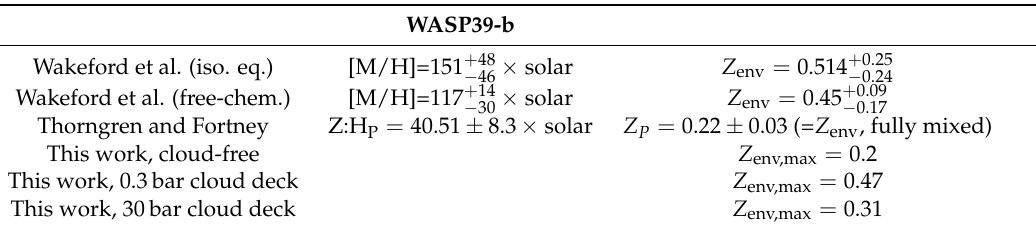
Figure 10. Range of envelope metallicity Z env due to different atmosphere models without clouds (blue), with optically thick cloud deck at 0.3 bar (purple), and optically thin at 30 bar (favored case, orange). Circles/diamonds indicate the maximum Z env value for a fully-mixed planet. The solid and dashed colored lines indicate models with different T int / (cid:101) -values obtained for the cloud-free models. The arrows indicate the increase of Z env when clouds are switched on. Table 3. Constraints on atmospheric metallicity of